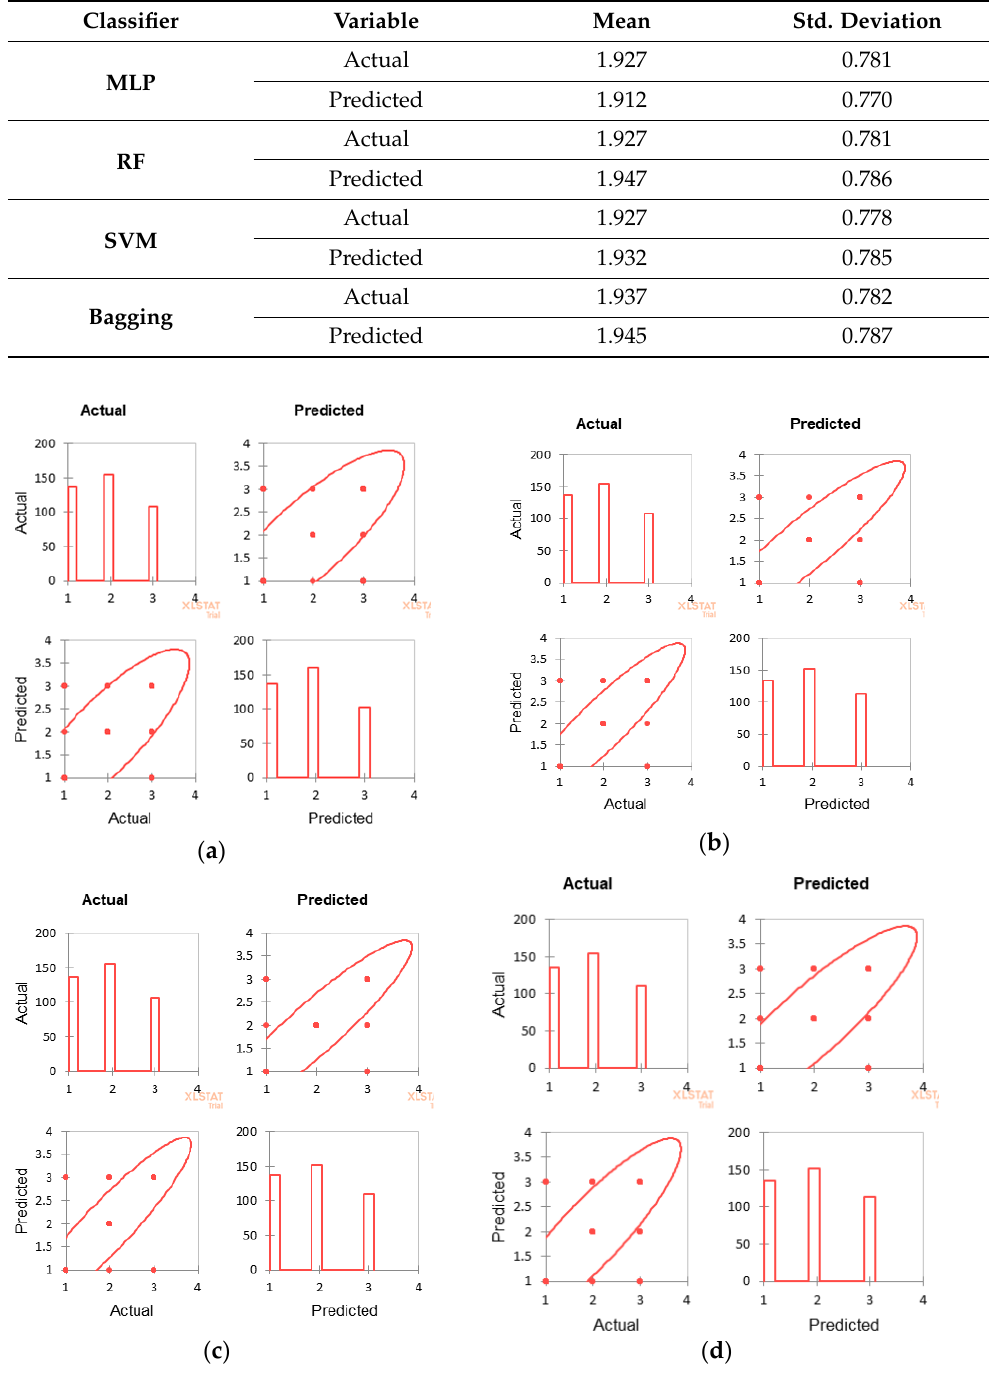
Figure 7. Scatter plots show the difference between the actual and predicted classifications. The bar charts show the number of instances in each class and the scatter plots show the number of outliers in each class for all four